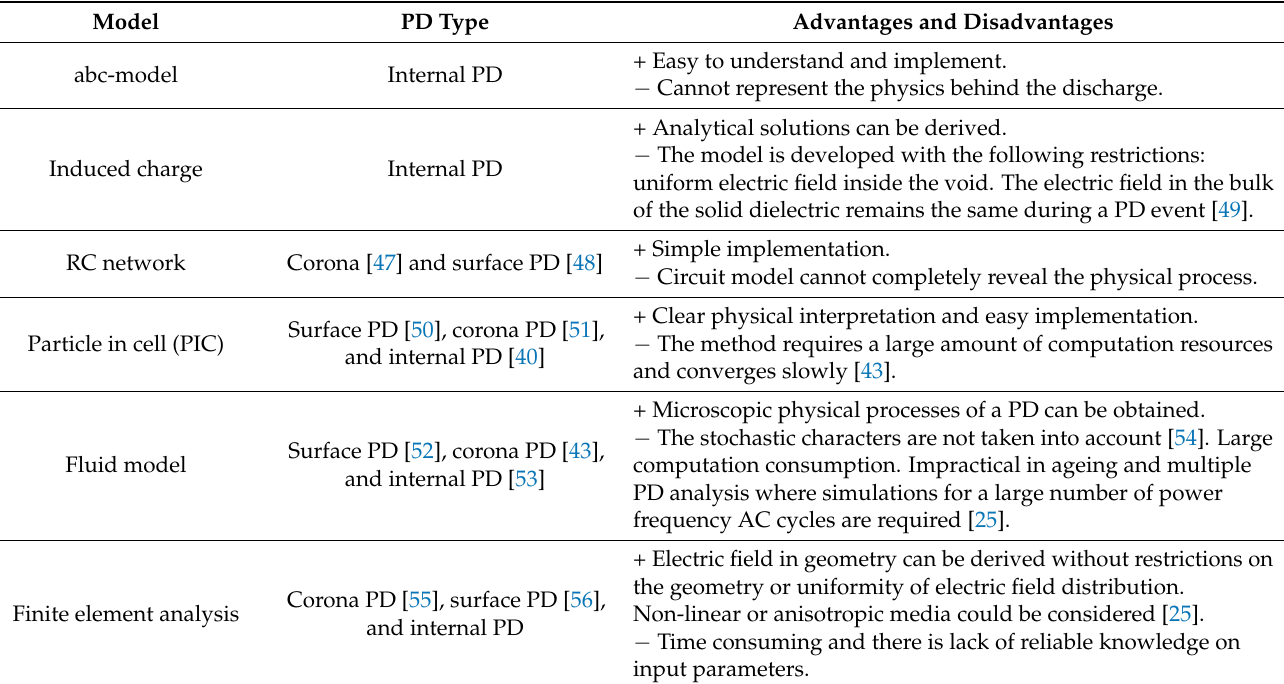
Table 1. PD models summary with advantages and